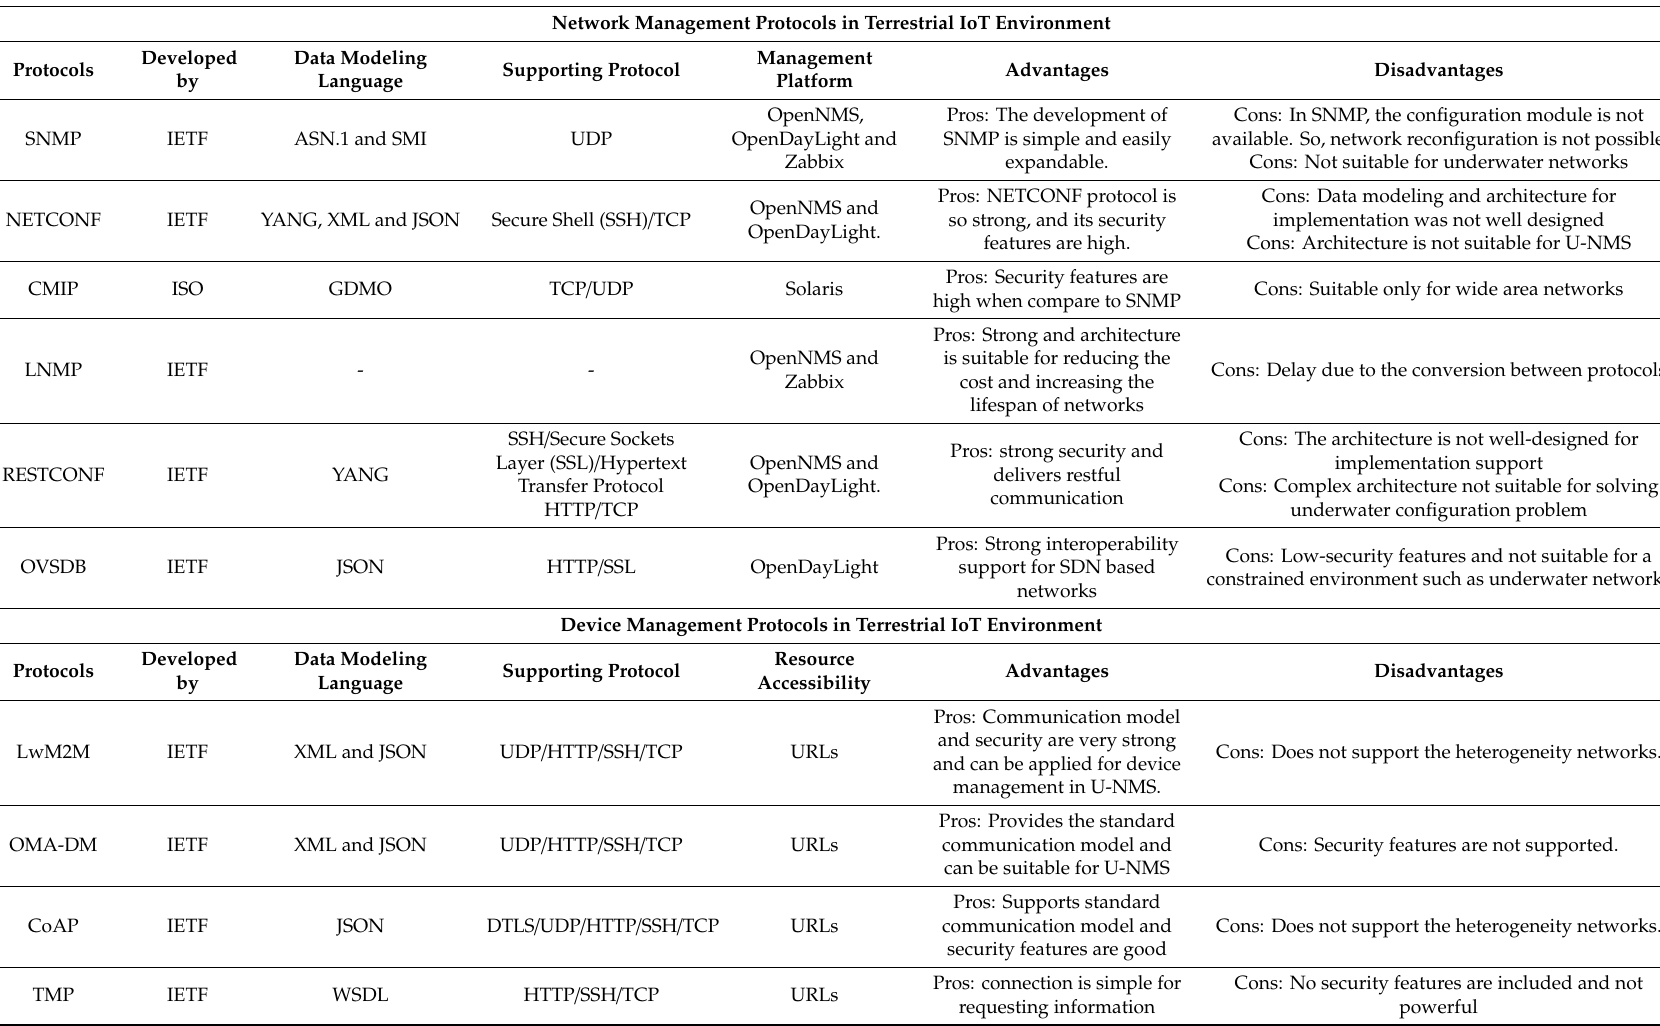
Table 1. Characteristics comparison of network management and device management protocols in terrestrial Internet of Things (IoT)